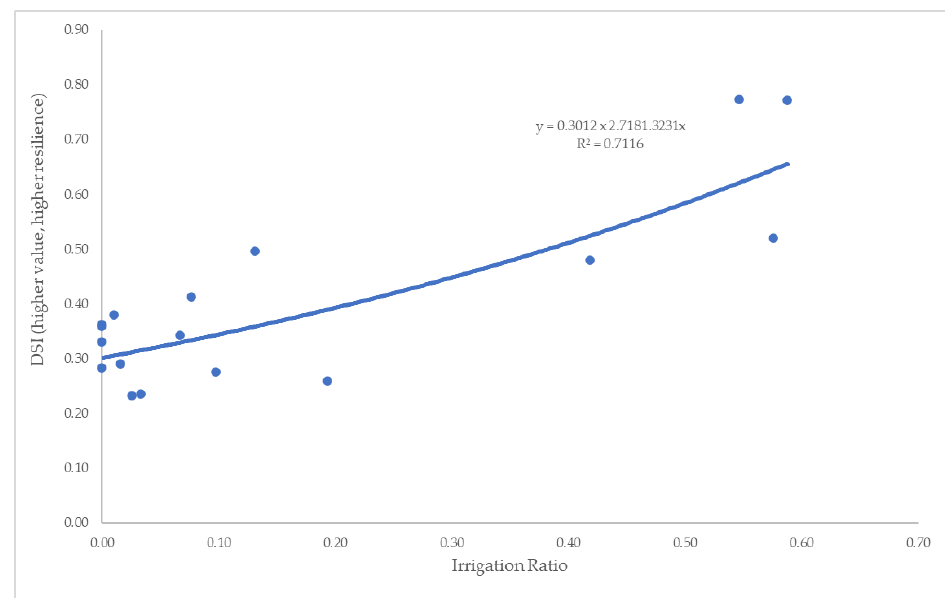
Figure 6. The relationship between irrigation ration by commune and their DSI value. Raw data, surveys, and case studies confirm that drought impacts in Cambodia are associated with human-made and climate factors. The raw data regarding rainfall